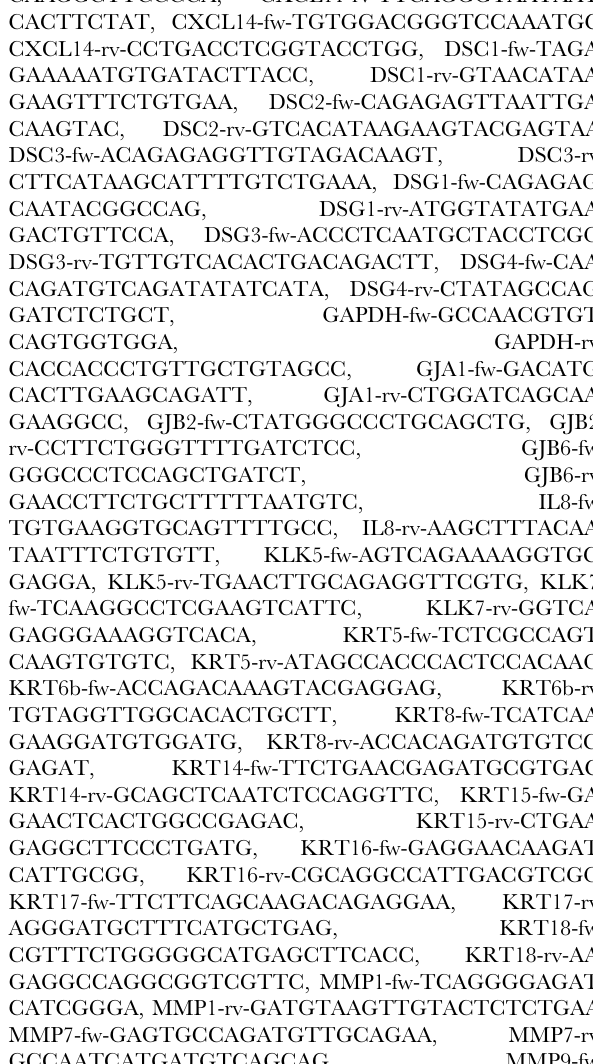
Table 2. Microarray analysis of kallikrein-related peptidases.